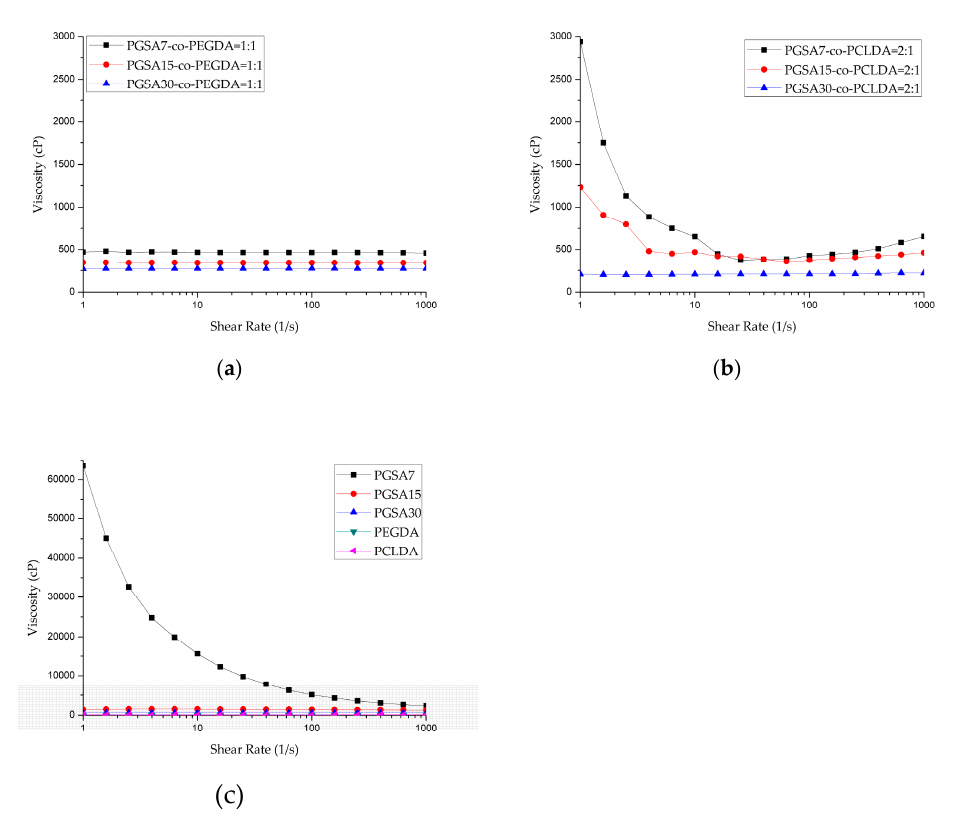
Figure 2. Apparent viscosity as a function of shear rate for ( a ) PGSA- co -PEGDA in various degree of acrylation; ( b ) PGSA- co -PCLDA in various degree of acrylation; ( c ) PEGDA, PCLDA, and PGSA prepolymers in various degree of acrylation. Note that PCLDA was measured at 40 °C instead of 25 °C according to the printing parameter of Cheng et al. [34]. Table 1. Average viscosity of PGSA, PEGDA, PGSA-co-PEGDA, and PGSA- co -PCLDA prepolymers with various degree of acrylation in comparison to PEGDA and PCLDA prepolymer ( n = 3).